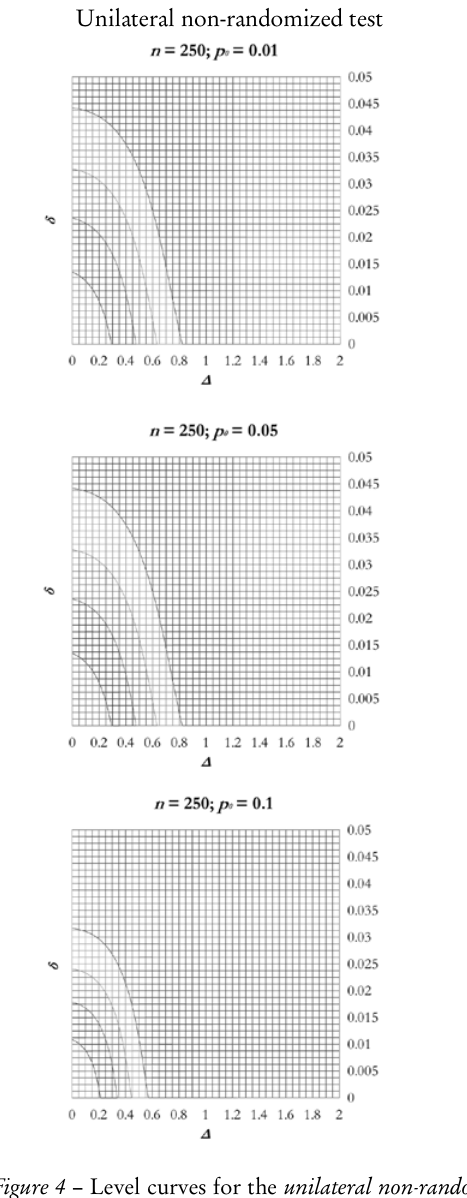
Figure 4 – Level curves for the unilateral non-randomized and randomized test for ' '' 2.5% α α= = ; 0.01, 0.05, 0.10 = n 250 = and p 0